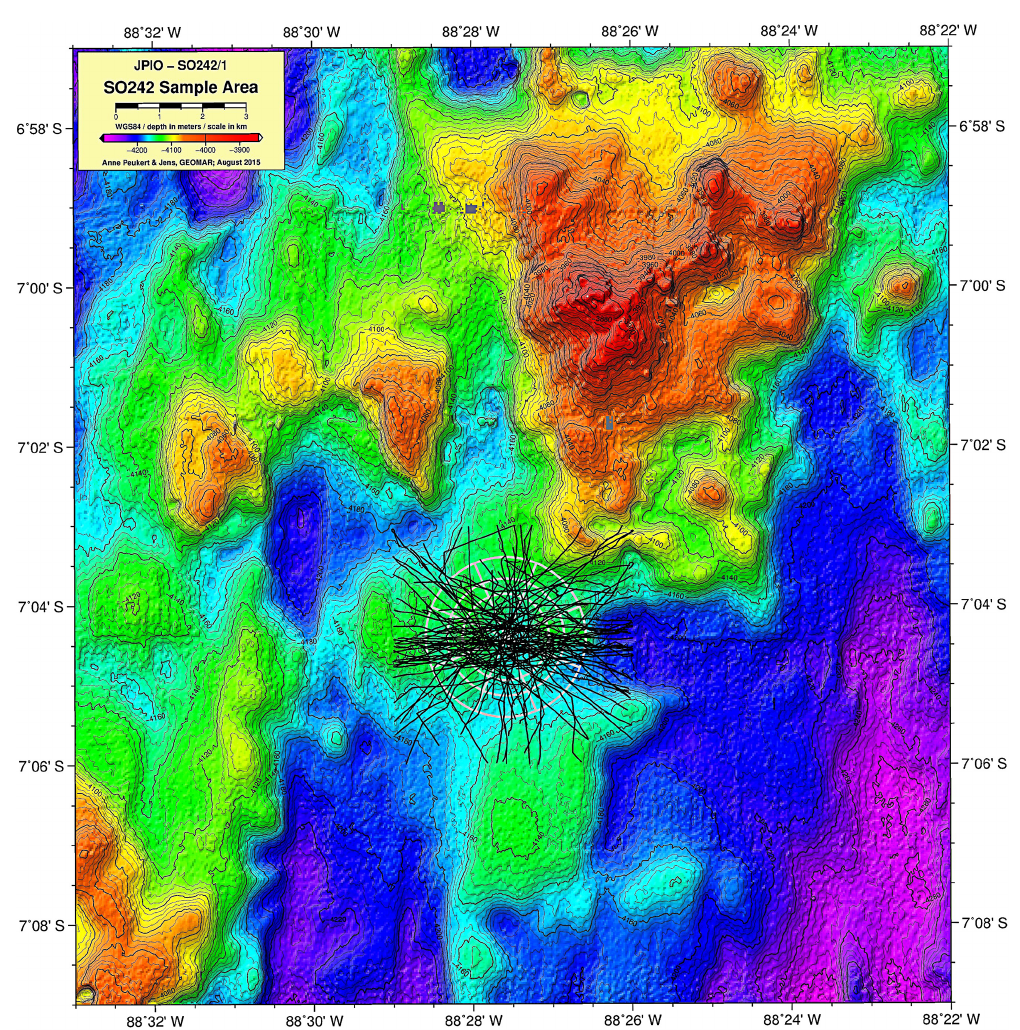
Figure A1. Multibeam scan showing the location of the 78 track marks created by the plough harrow in the DisCOL experimental area to simulate manganese nodule extraction activity